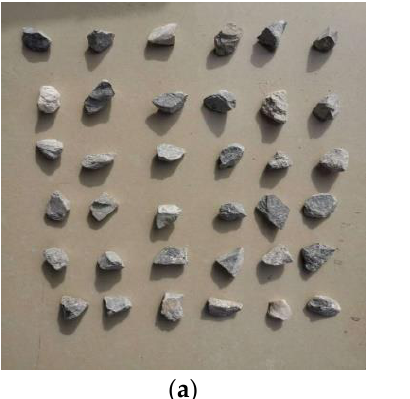
Figure 2. Changes in the angularity of aggregates.